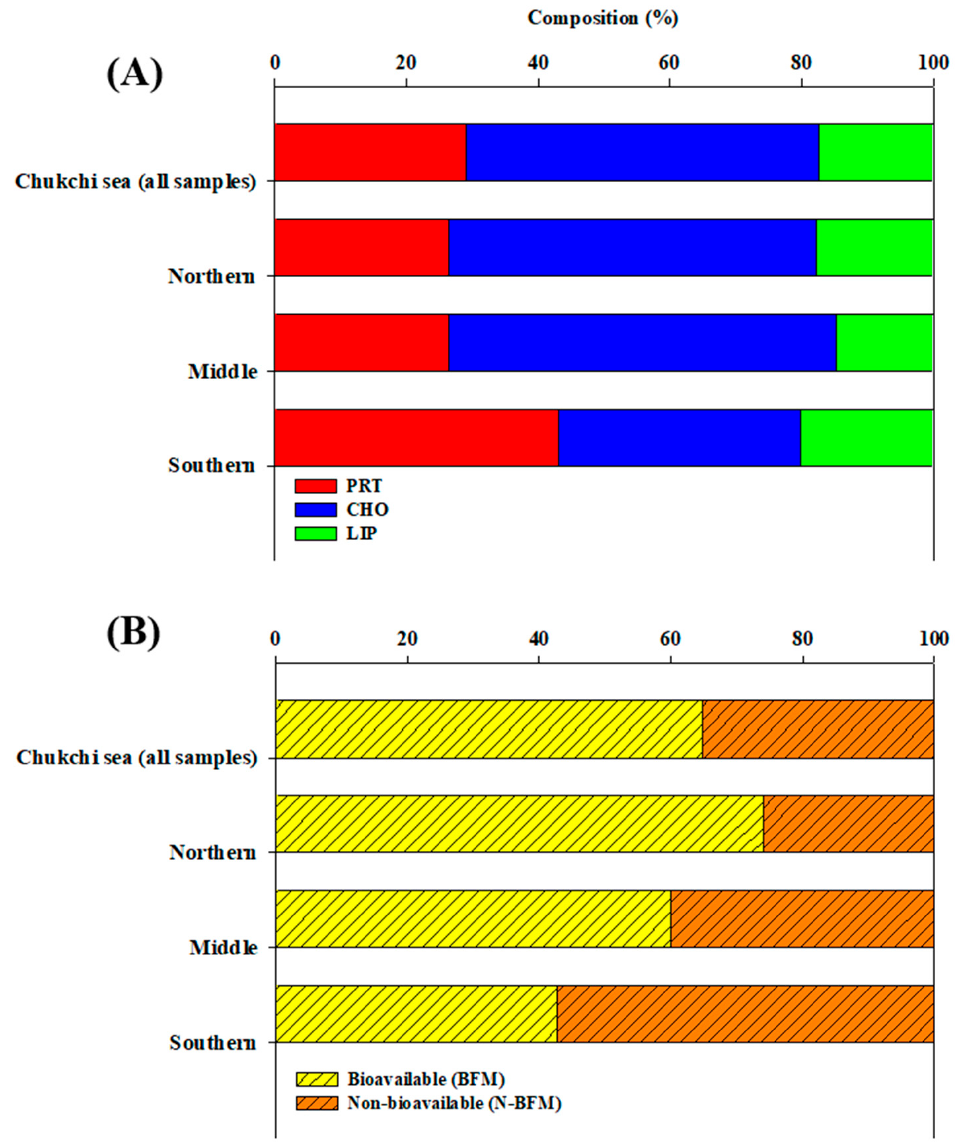
Figure 6. Spatial distribution of ( A ) specific biochemical compositions (PRT, CHO, and LIP) and ( B ) percentage non-bioavailable (N-BFM; non-hydrolysable) and bioavailable (BFM; hydrolysable, sum of hydrolysable PRT (HPRT), hydrolysable CHO (HCHO), and hydrolysable LIP (HLIP) concentration) fractions in each group (southern, middle, and northern part) and all samples (Chukchi Sea). Composition of the hydrolysable pool was deduced by subtraction of the non-hydrolysable pools from those of the total POM.